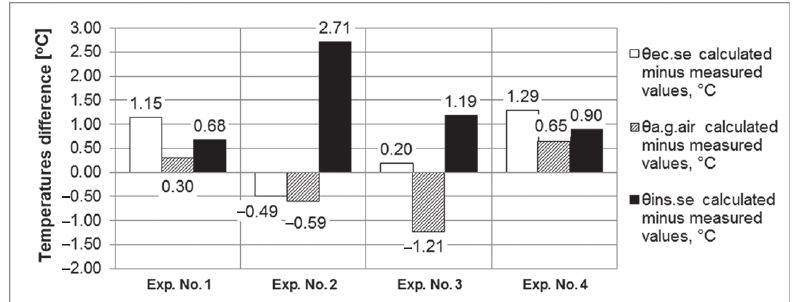
Fig. 5. absolute error in the calculation of average daily temperatures θ a.g.air , θ ins.se and θ ec.se by eqns (13)–(36)